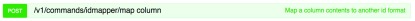
Swagger documented function.The functionality of idmapper is contained in this single function:
map column.